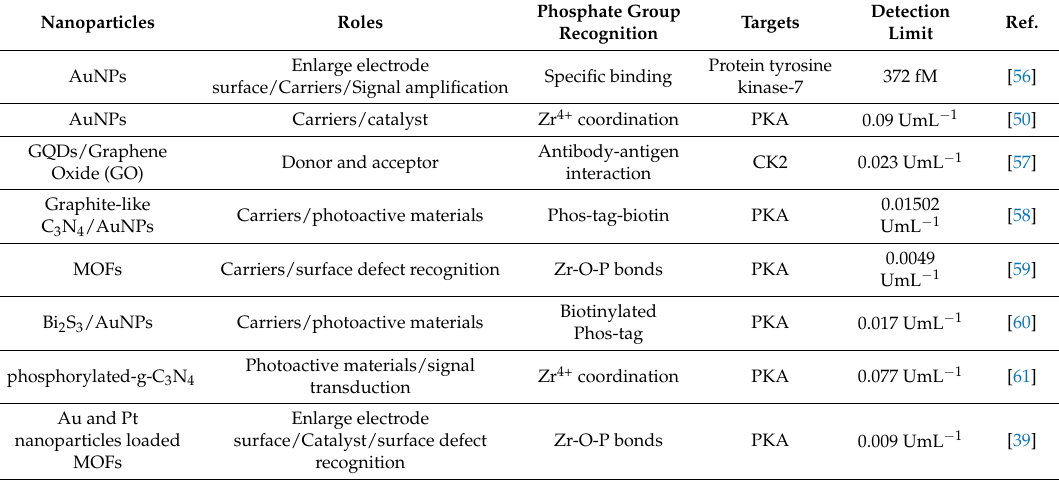
Table 1. Recent typical applications of nanomaterial-based electrochemical biosensors for protein kinase activity